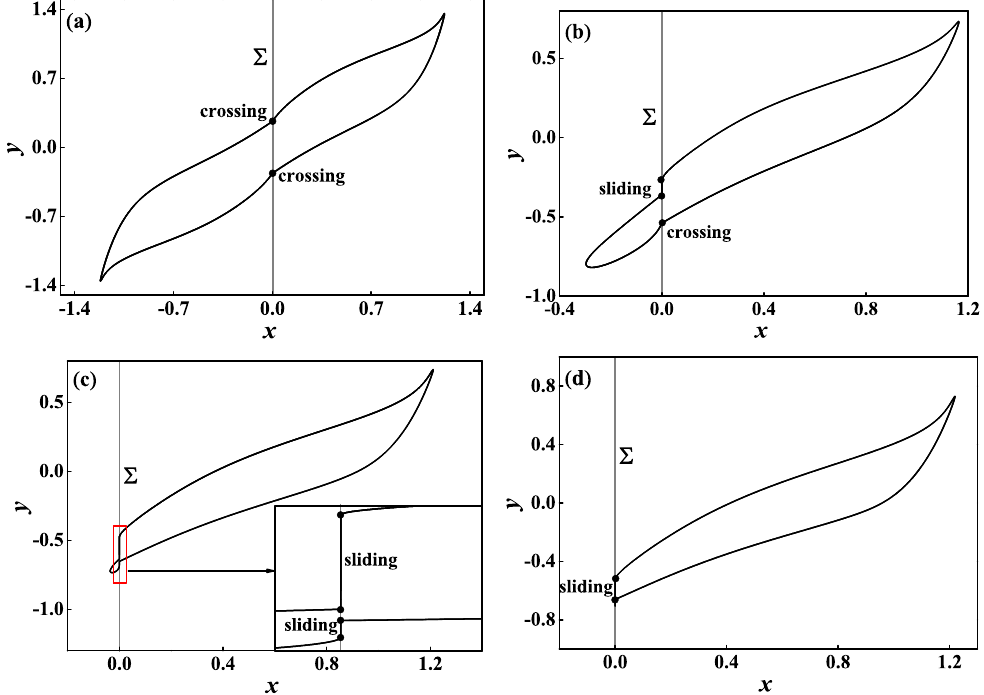
Figure 4. The limit cycle LCs with respect to different slow variable values: ( a ) double crossing mode with w = 0; ( b ) crossing sliding mode with w = 0.38; ( c ) double sliding mode with w = 0.58; ( d ) single sliding mode with w =